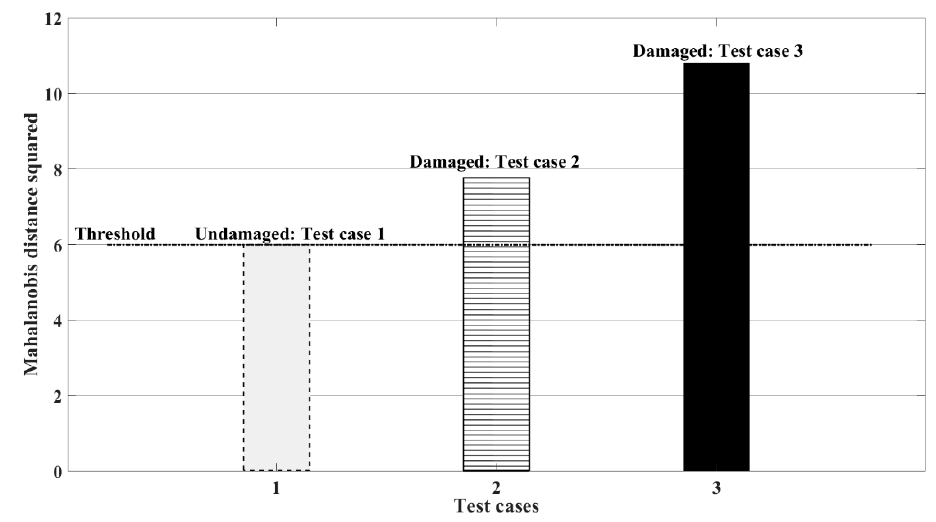
Figure 20. Mahalanobis distance as an indicator of damage to the experimental setup; test case 1: Healthy case, test case 2: 24.5% scour at Pier 2, test case 3: 44.9% scour at Pier 2.